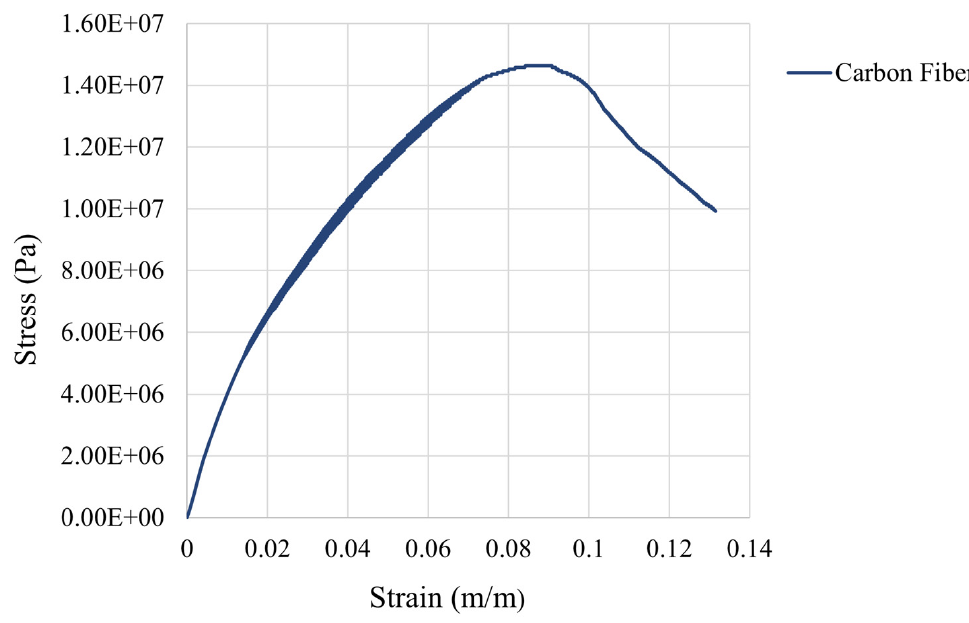
Figure 3. Stress–strain curves for five different reinforcement types.